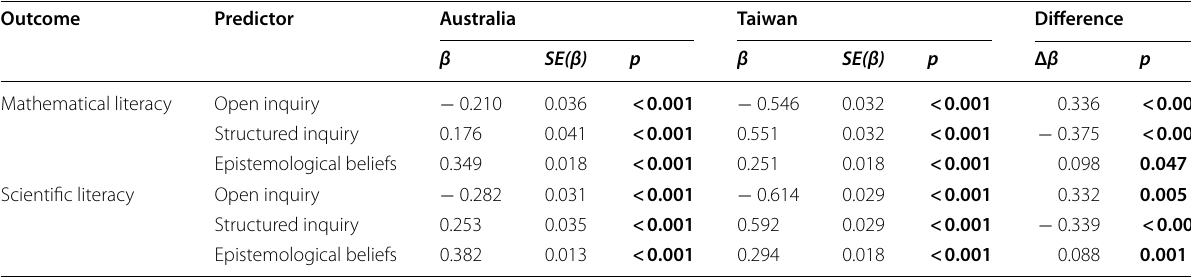
For mathematical literacy, R 2 statistically significant ( p < 0.05) predictive effects